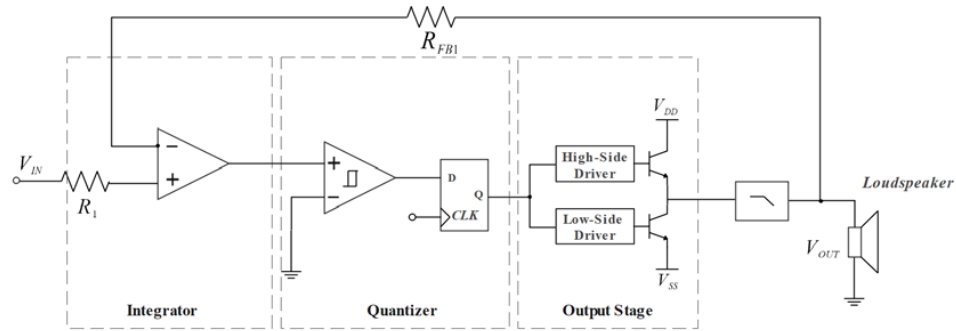
Figure 12. Self-oscillating Class D amplifiers block diagram.